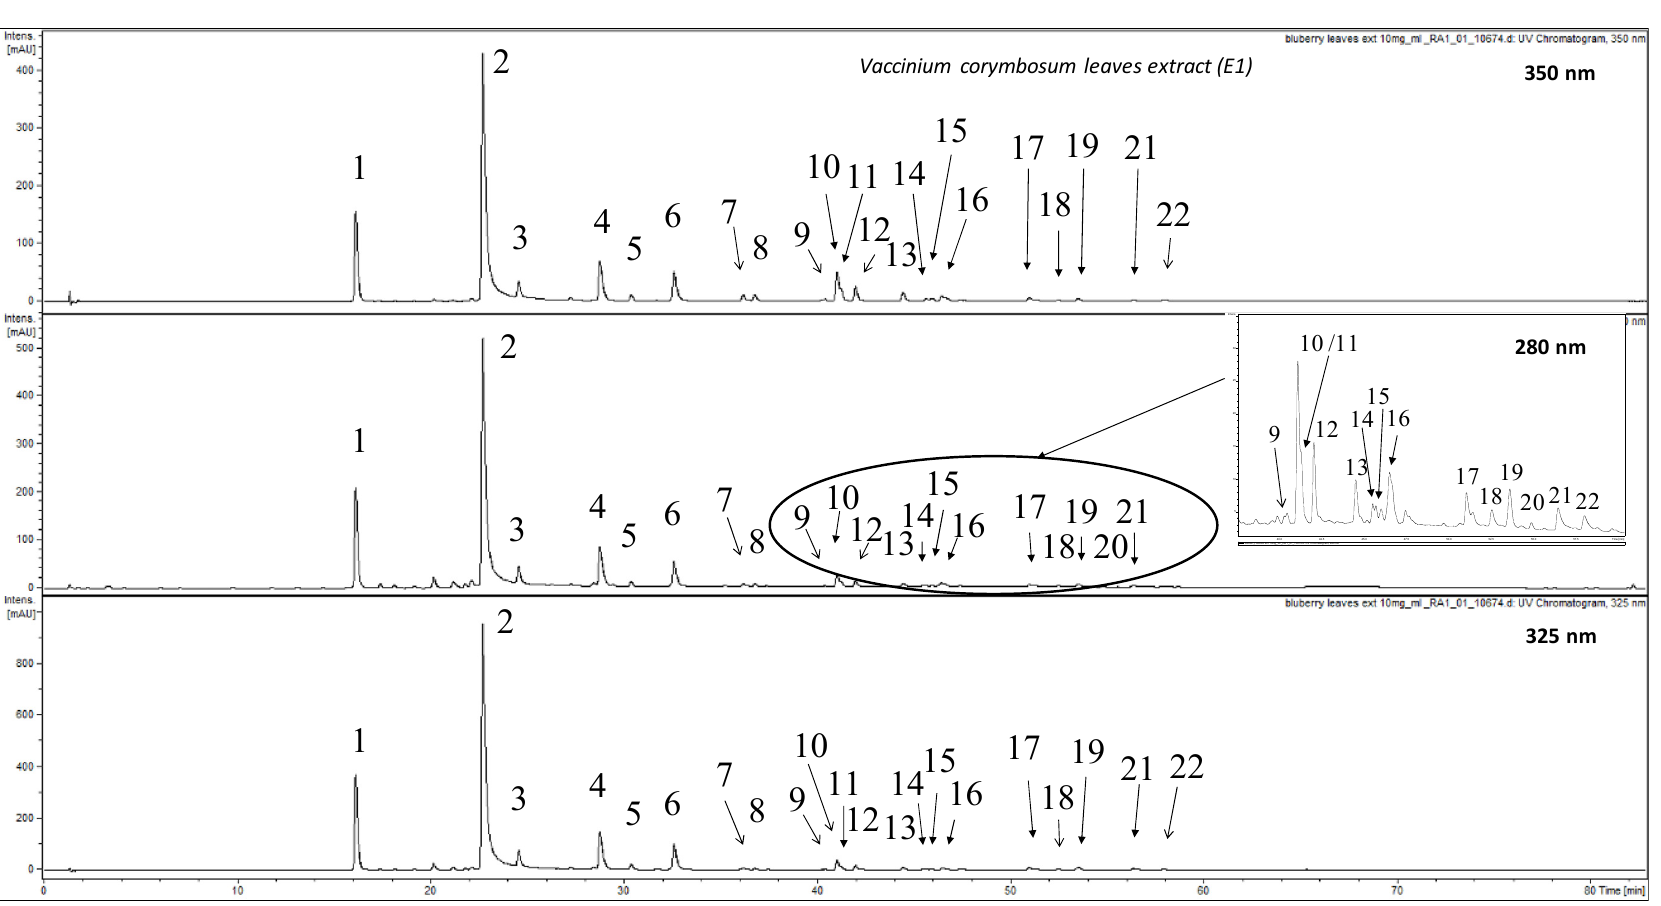
Figure 1. HPLC-DAD-MS chromatogram of E1 recorded at 350, 280 and 325 nm.